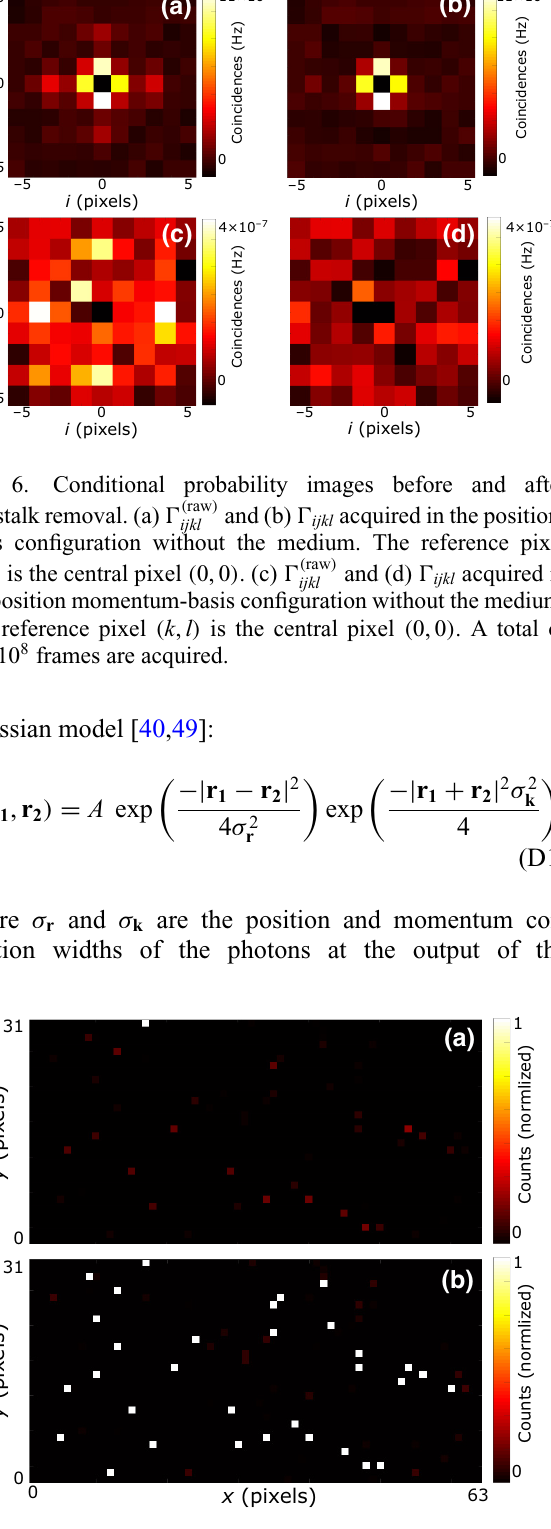
FIG. 7. The identification of hot pixels. (a) An intensity image obtained by summing 1.2 × 10 9 frames acquired with no light on the sensor. (b) The same image with the 32 identified hot pixels appearing in